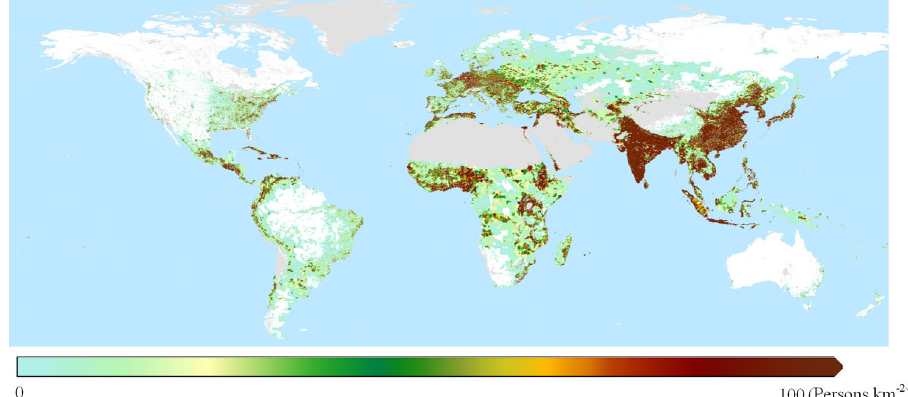
Fig. 5 Distribution of world population density. Gray background is non-vegetated (see biomes de fi nition in Supplementary Table 3) that is excluded from analysis and white areas show population density 0.